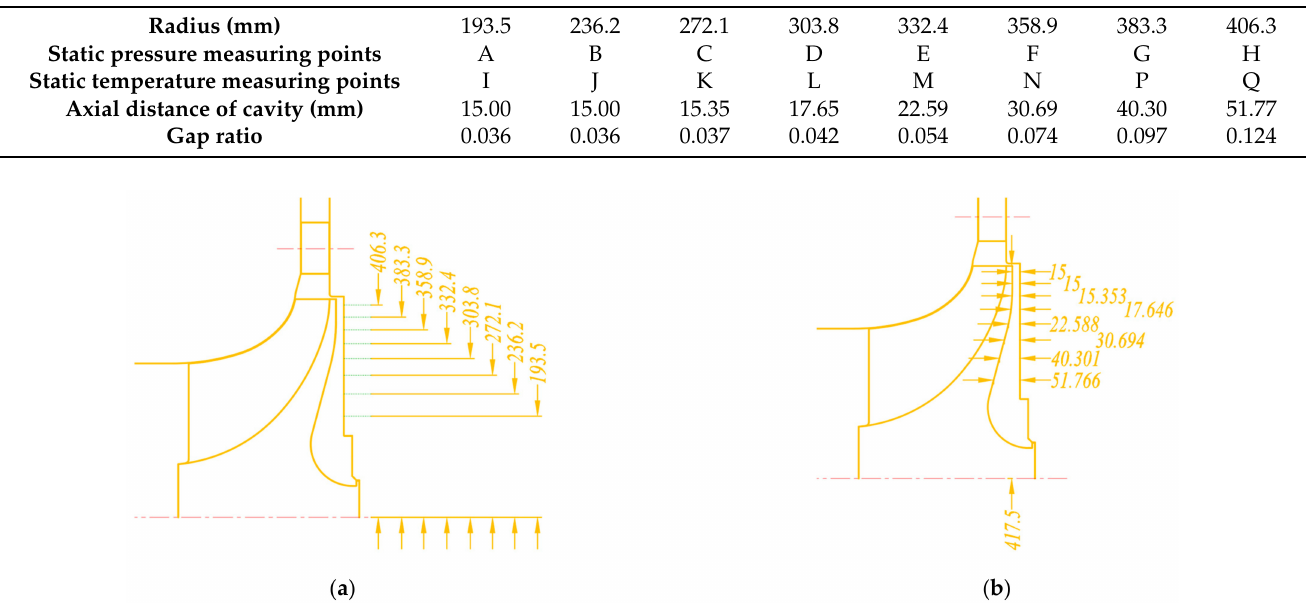
Figure 3. Zoom figure of the measuring points in IBC: ( a ) measuring point radius; ( b ) axial clearance of measuring point.